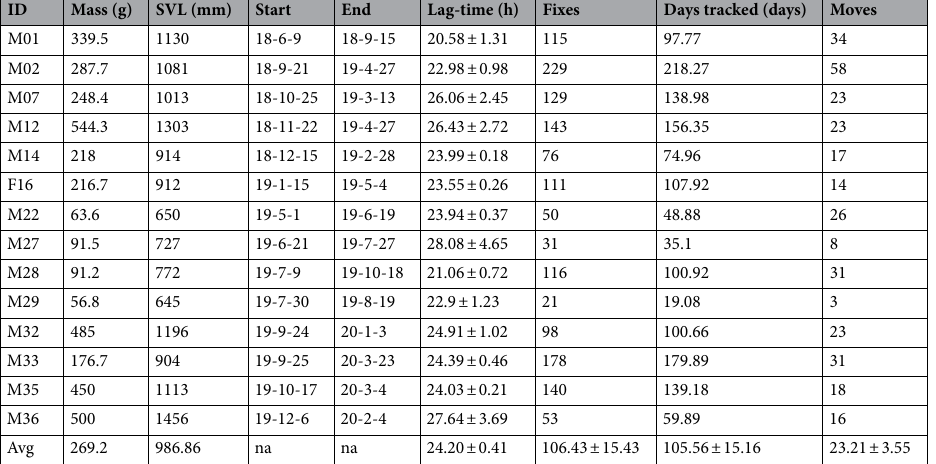
Table 1. Morphometric and tracking data for each telemetered B. candidus . Mass, snout-to-vent length (SVL), tracking start and end dates (shown as year–month–day), lag-time between location checks (h), number of fixes, duration tracked (days), and number of relocations (i.e., moves) shown with overall averages (for all include, n =